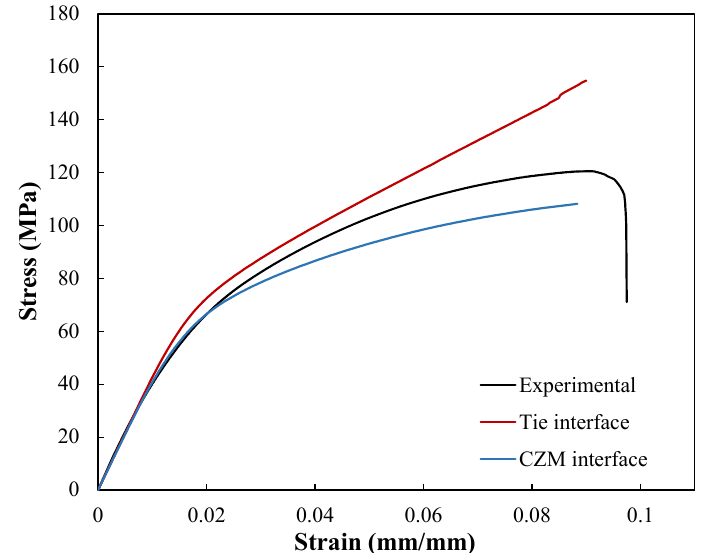
Figure 10. Stress-strain curves of the numerical simulation versus the experimental tensile test.